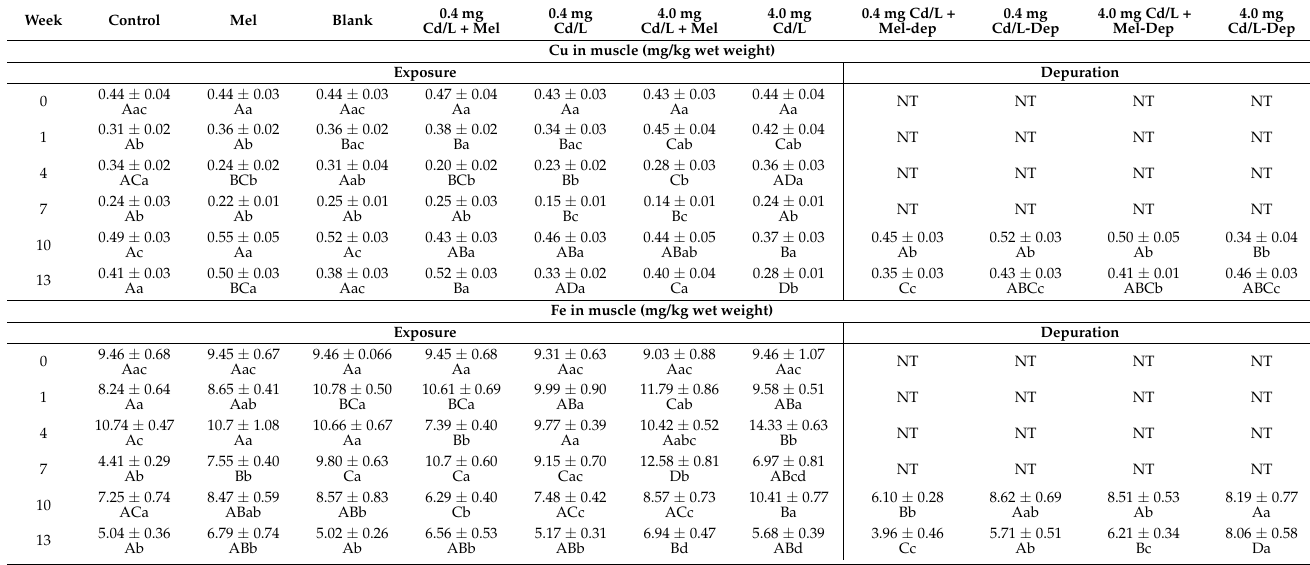
Table 5. Comparison of Cu and Fe levels (mg/kg ww) in the muscles of female Prussian carp during 13 weeks of fish exposure to different doses of cadmium and 6 weeks